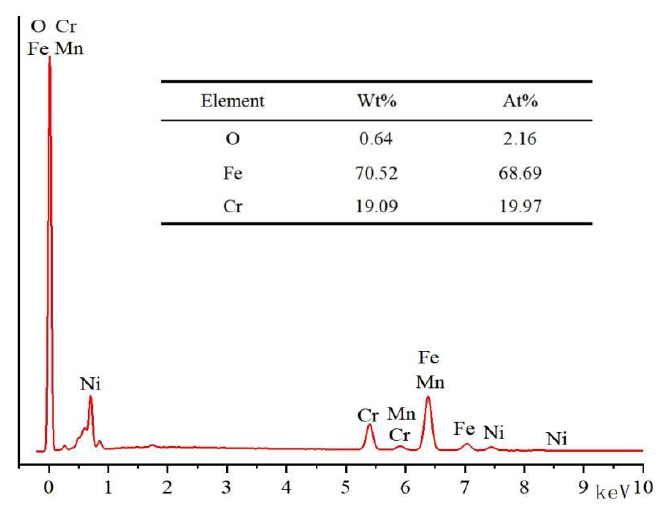
Figure 4. Main elements of the substrate.